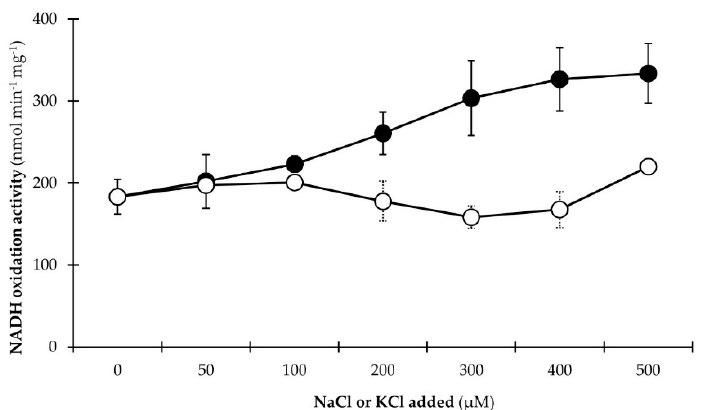
Figure 5. Stimulation of NADH:quinone oxidoreduction activity of P. bryantii B 1 4 membranes by Na + . The assay mixture contained membranes (aliquots of 50 µg protein), 20 mM Tris-HCl (pH 7.5), 100 µM NADH, and 100 µM ubiquinone-1. To the assay mixture, 0–500 µM NaCl ( ● ) or KCl ( ○ ) were added. The residual Na + concentration in every samples was 40 µM. The oxidation of NADH was followed spectrophotometrically at 25 °C. Mean values and SD are from n = 3 measurements.